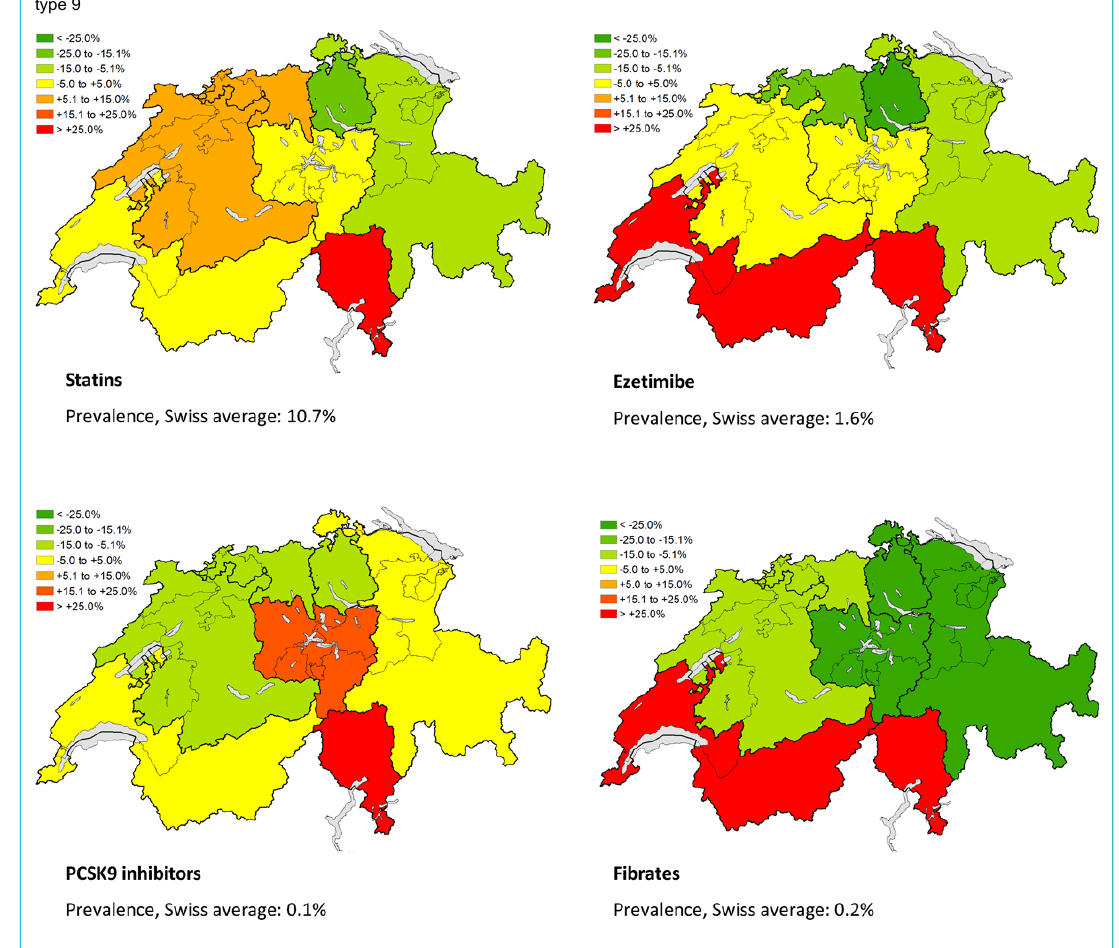
Figure 2: Relative deviation of the prevalence of patients with ≥1 filled prescription of a lipid-lowering drug from the Swiss average in the year 2019, by major statistical region and drug class, extrapolated to the Swiss population level. PCSK9 = proprotein convertase